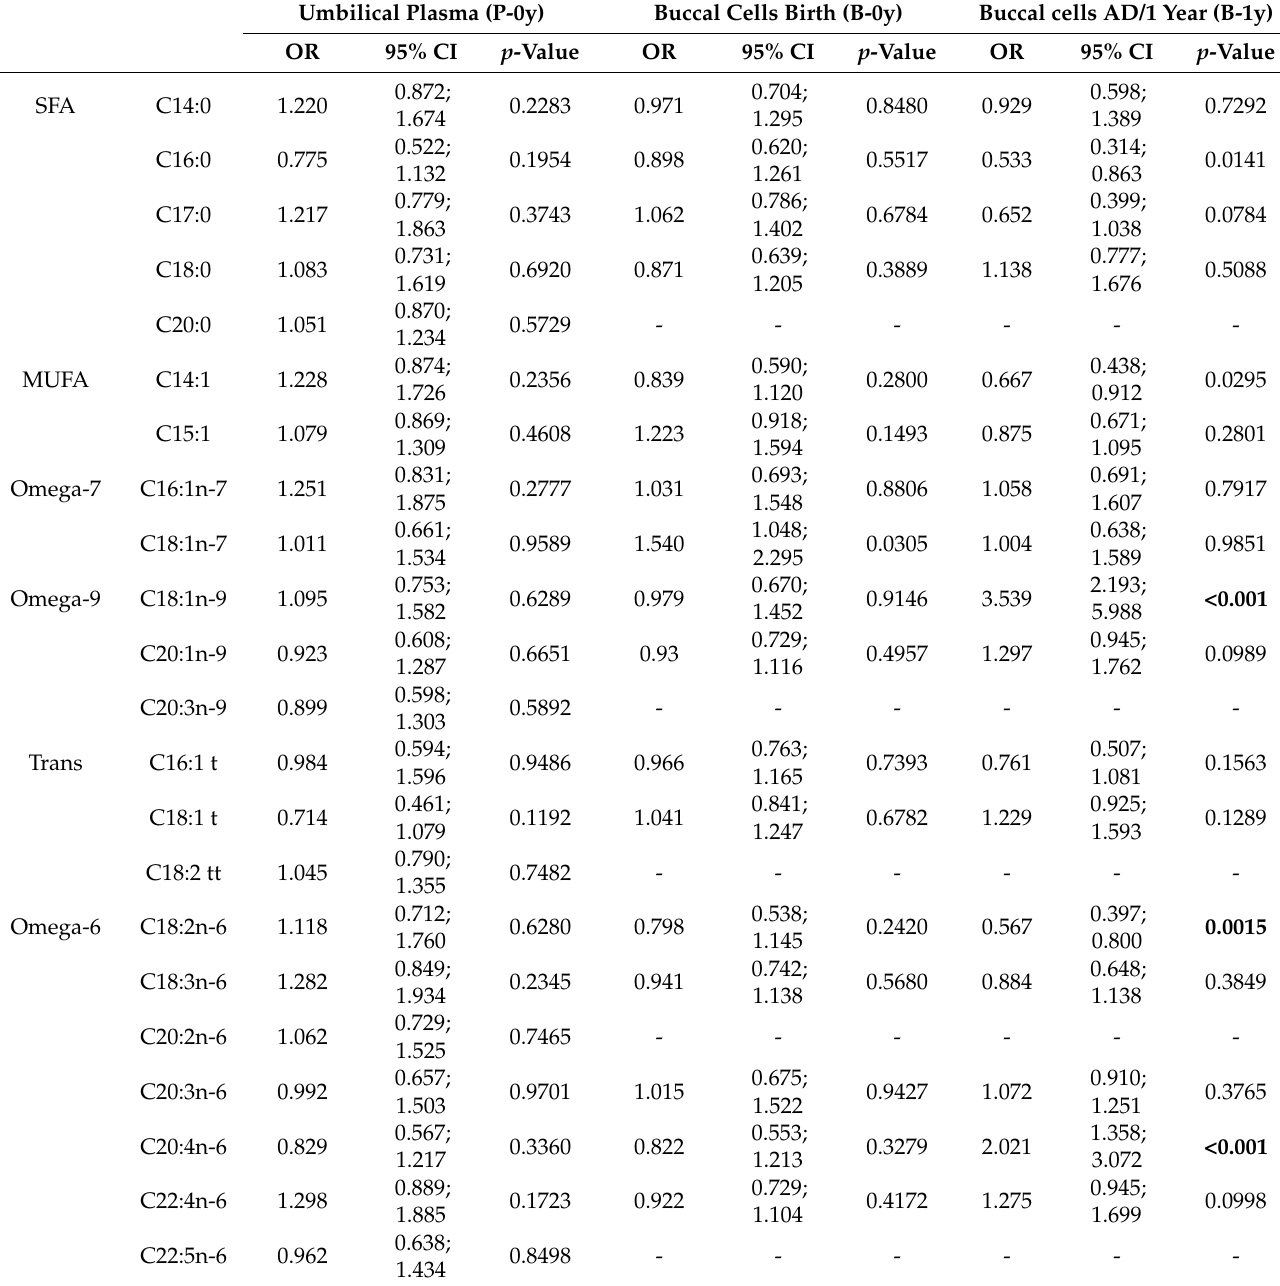
Table 3. Associations of GPL-FAs with